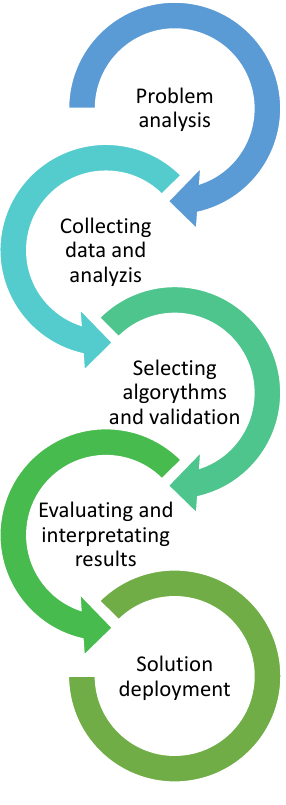
Figure 2. Analysis scheme using machine learning.